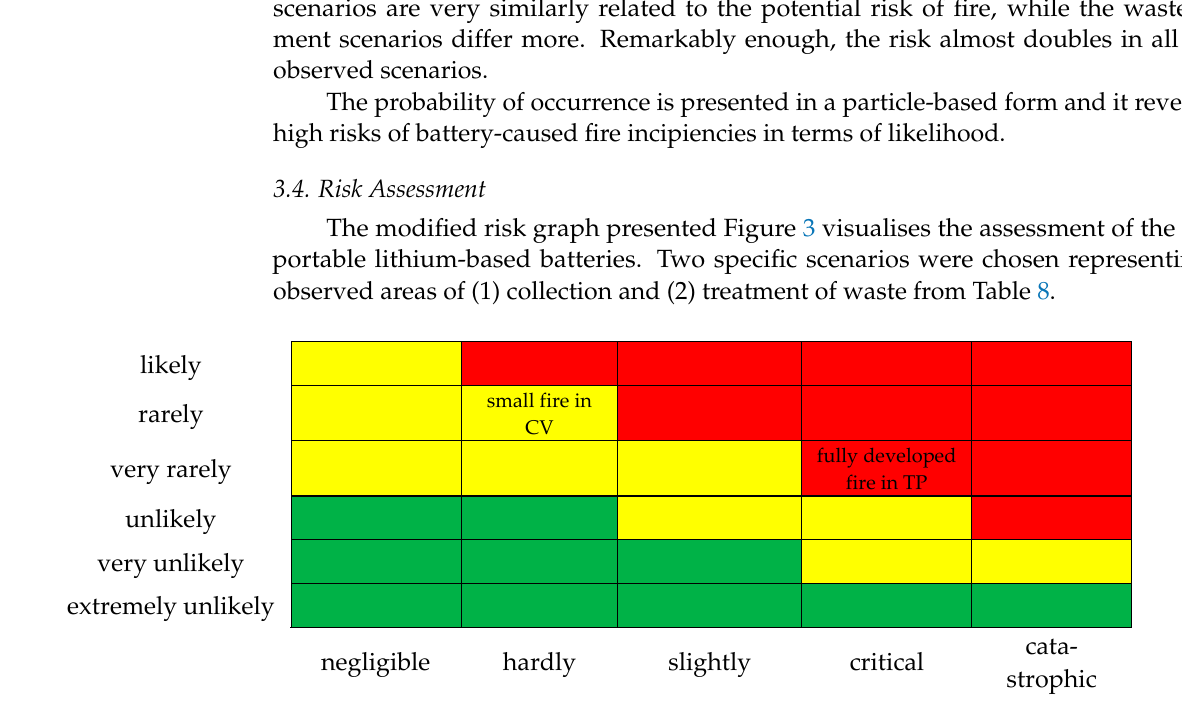
Figure 3. Modified risk graph for the two scenarios of Table 8: Waste collection (a small fire in a collection vehicle, CV) and waste treatment (a fully developed fire in a treatment plant, TP).